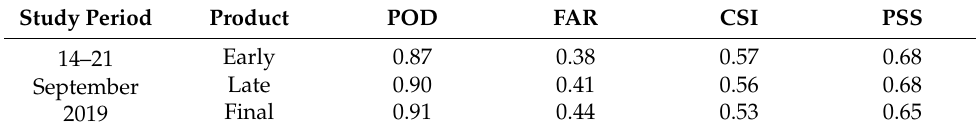
Figure 13. Spatial distribution of PSS for the IMERG ( A ) Early-, ( B ) Late-, and ( C ) Final-run products during Tropical Storm Imelda. Table 3. The areal average of the probabilistic statistical indices of the satellite products. Study Period